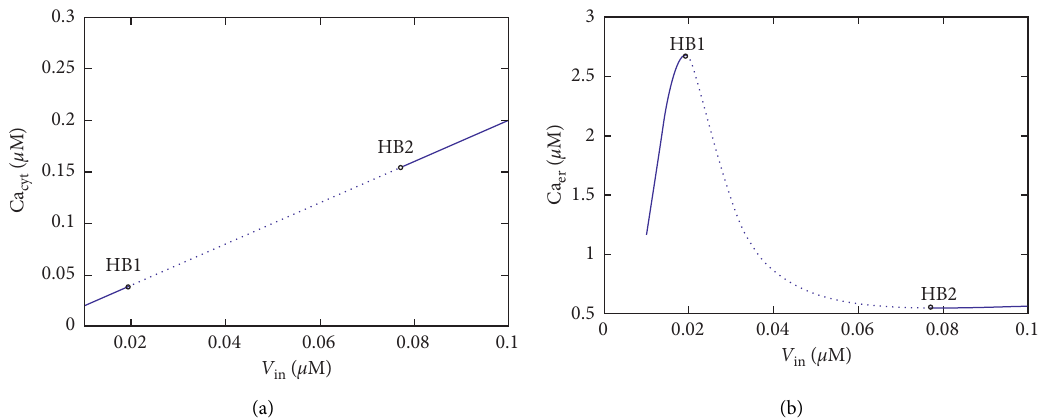
Figure 5: (a) Bifurcation diagram of the whole system versus the parameter v whole system versus the parameter v supercritical Hopf bifurcation point,